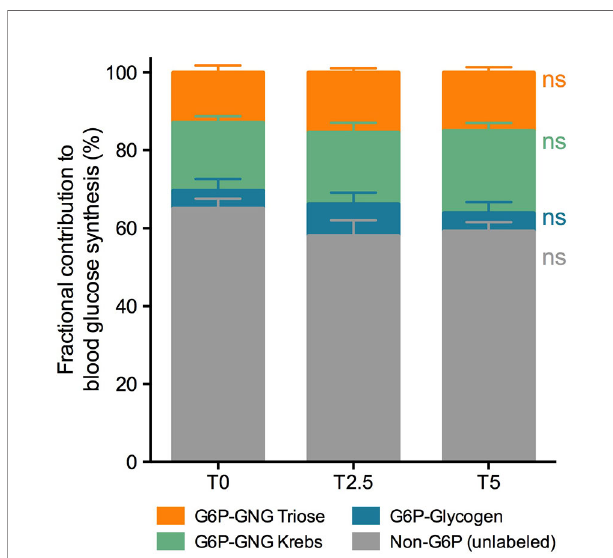
FIGURE 3 | Fractional contribution to blood glucose synthesis of rainbow trout ( Oncorhynchus mykiss ) fed with different levels of glycerol (0, 2.5, and 5%) for 8 weeks. Contributions are represented as percentage of total (%). Values are mean ± SEM (n = 12; one-way ANOVA; followed by Tukey for p < 0.05; ns, not signi fi cant). The color scheme corresponds to metabolic pathways depicted in Figure 1 .